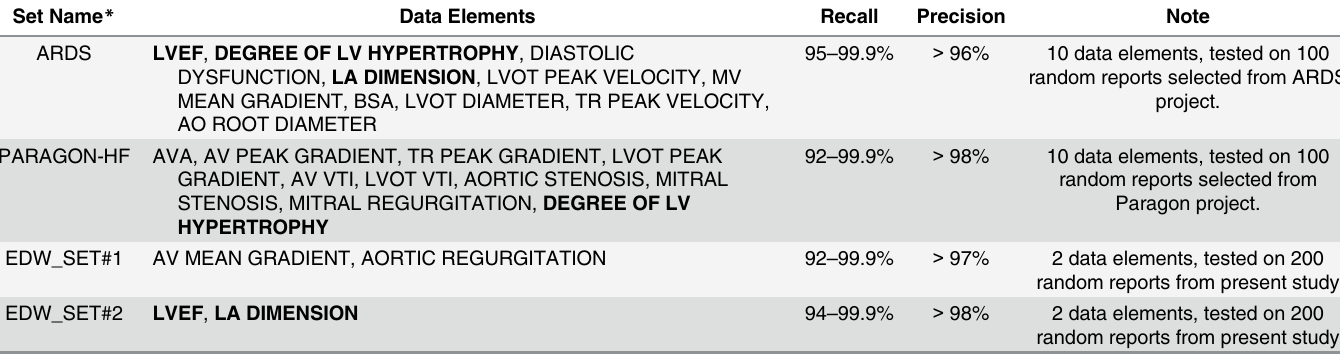
Table 4. Summary on precision and recall for 21 different random data elements validated on multiple data sets of echocardiographic